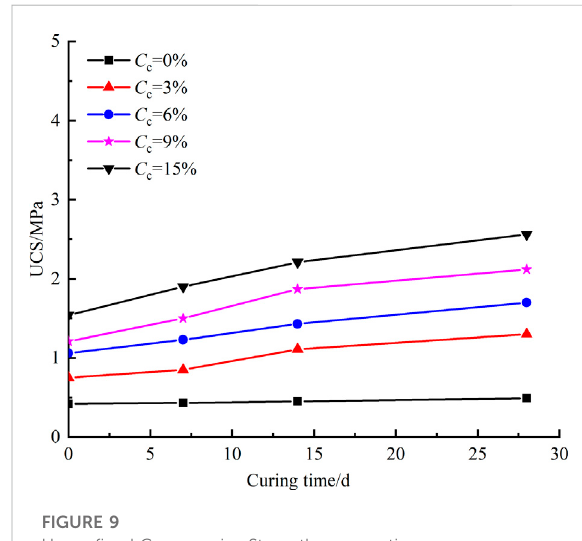
FIGURE 9 Uncon fi ned Compressive Strength vs. cure